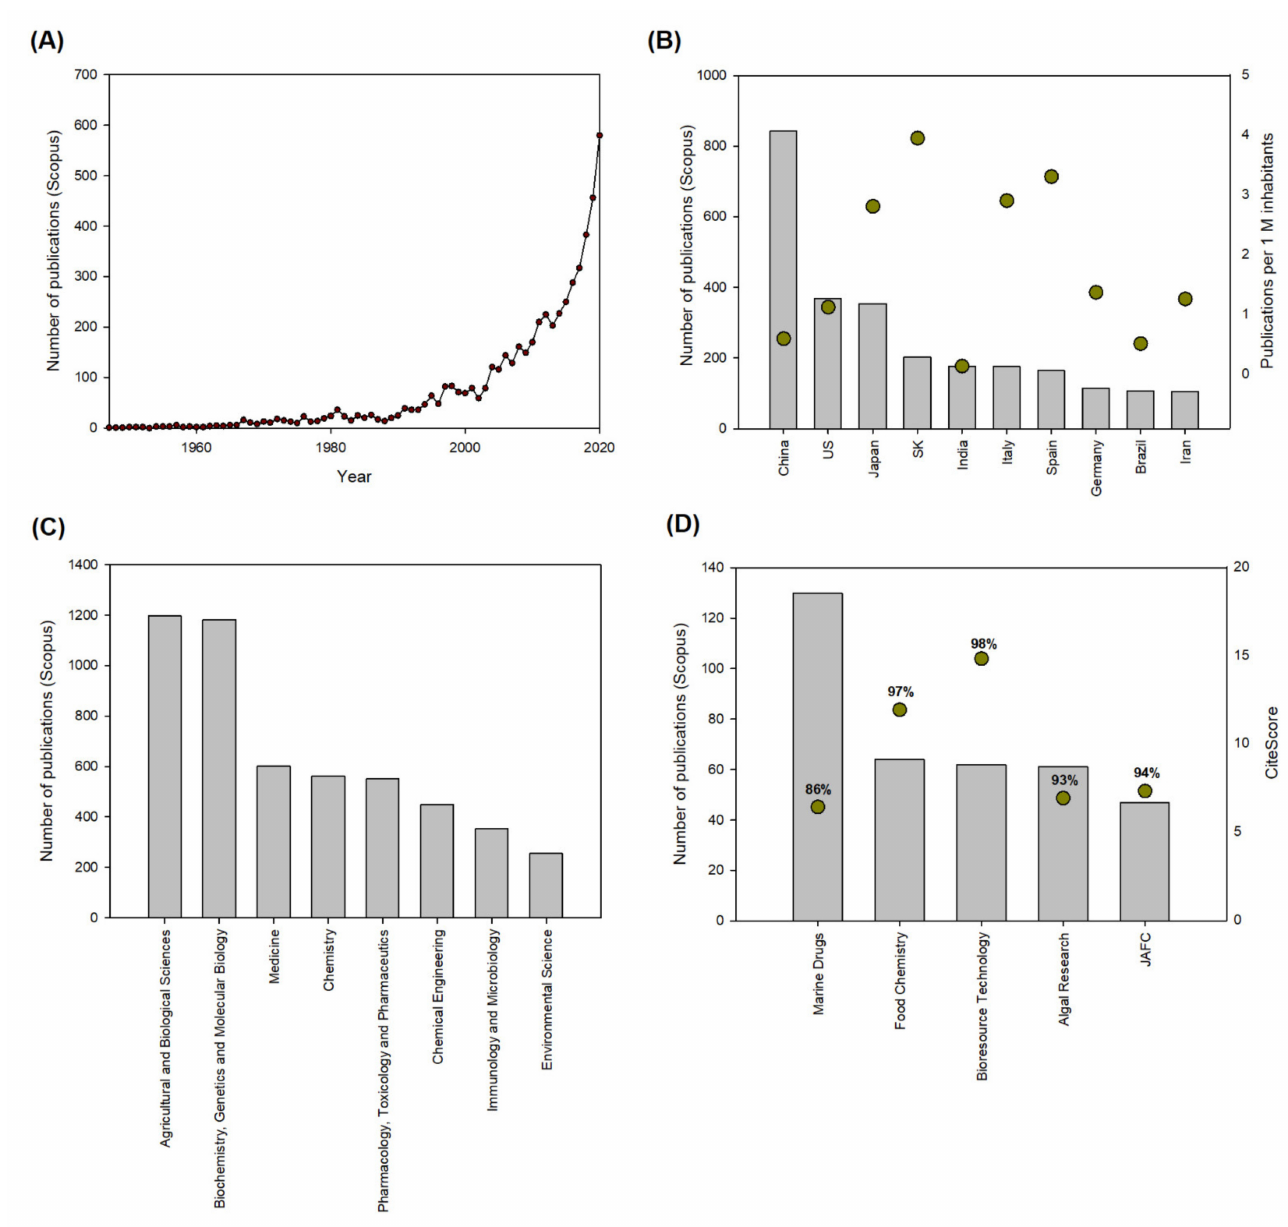
Figure 2. Bibliometric analysis. ( A ) Distribution of publications per year and most relevant ( B ) countries, ( C ) subject areas, and ( D ) source titles of articles published 2010–2020. Abbreviations: US, United States; SK, South Korea; JAFC, Journal of Agricultural and Food